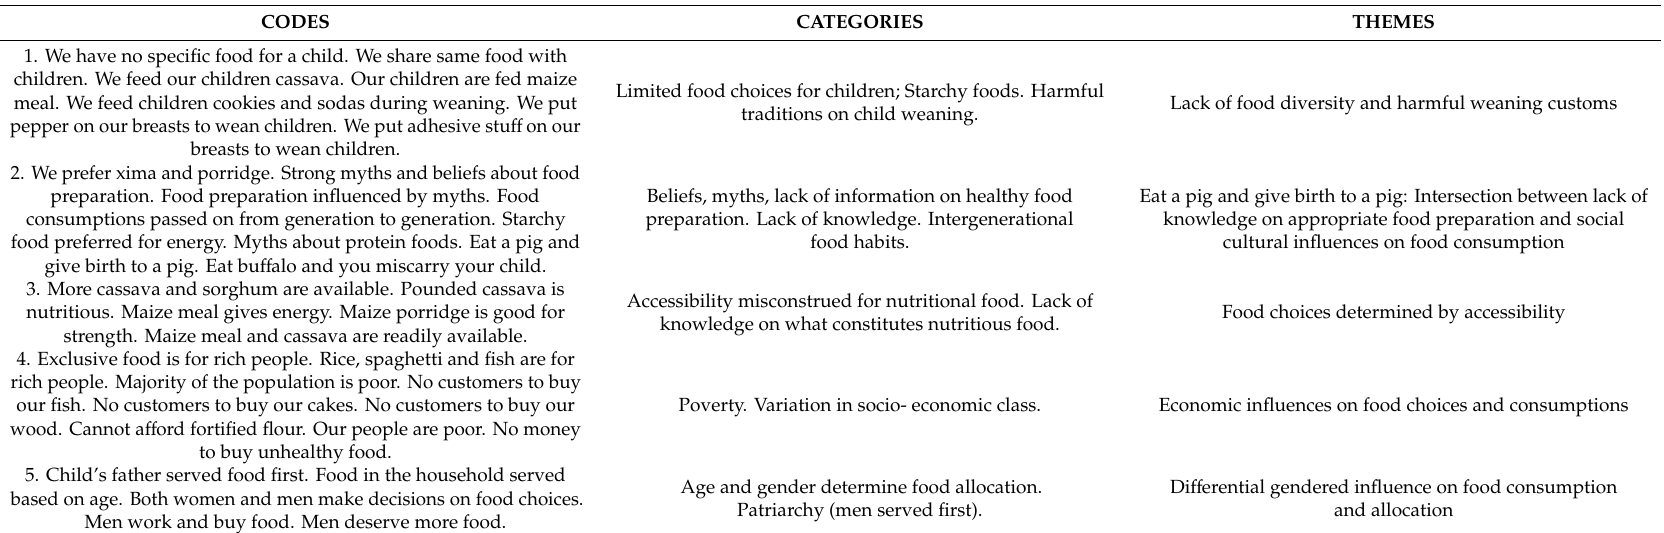
Table 2. Codes, categories and